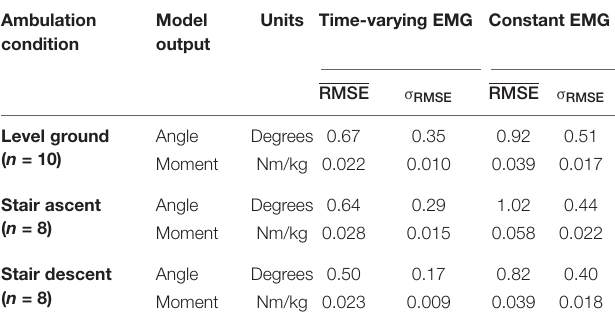
TABLE 2 | Temporal average of the instantaneous RMSE calculated across participants for the NARX models using the participant’s time-varying EMG as input and the NARX models using the average EMG as a constant